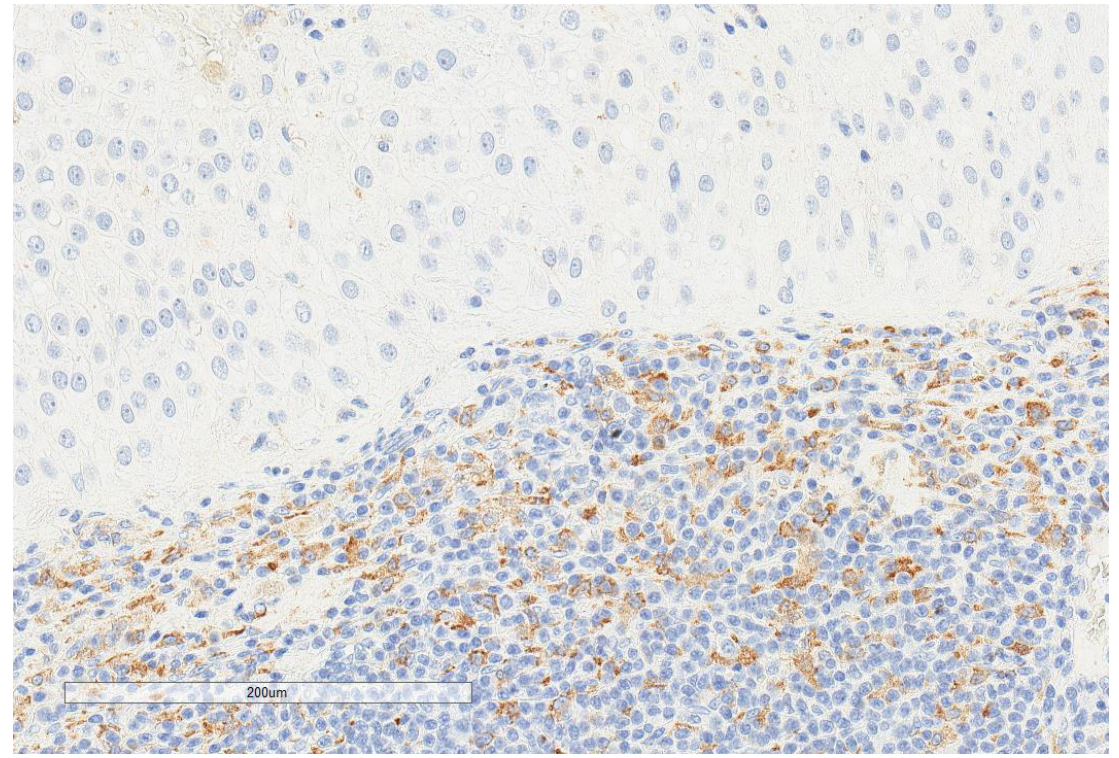
Figure 1. Representative microscopic image (×200 magnification) of high CD163 expression. The upper part of the image shows the tumor, and the lower part shows the inflammatory cells.